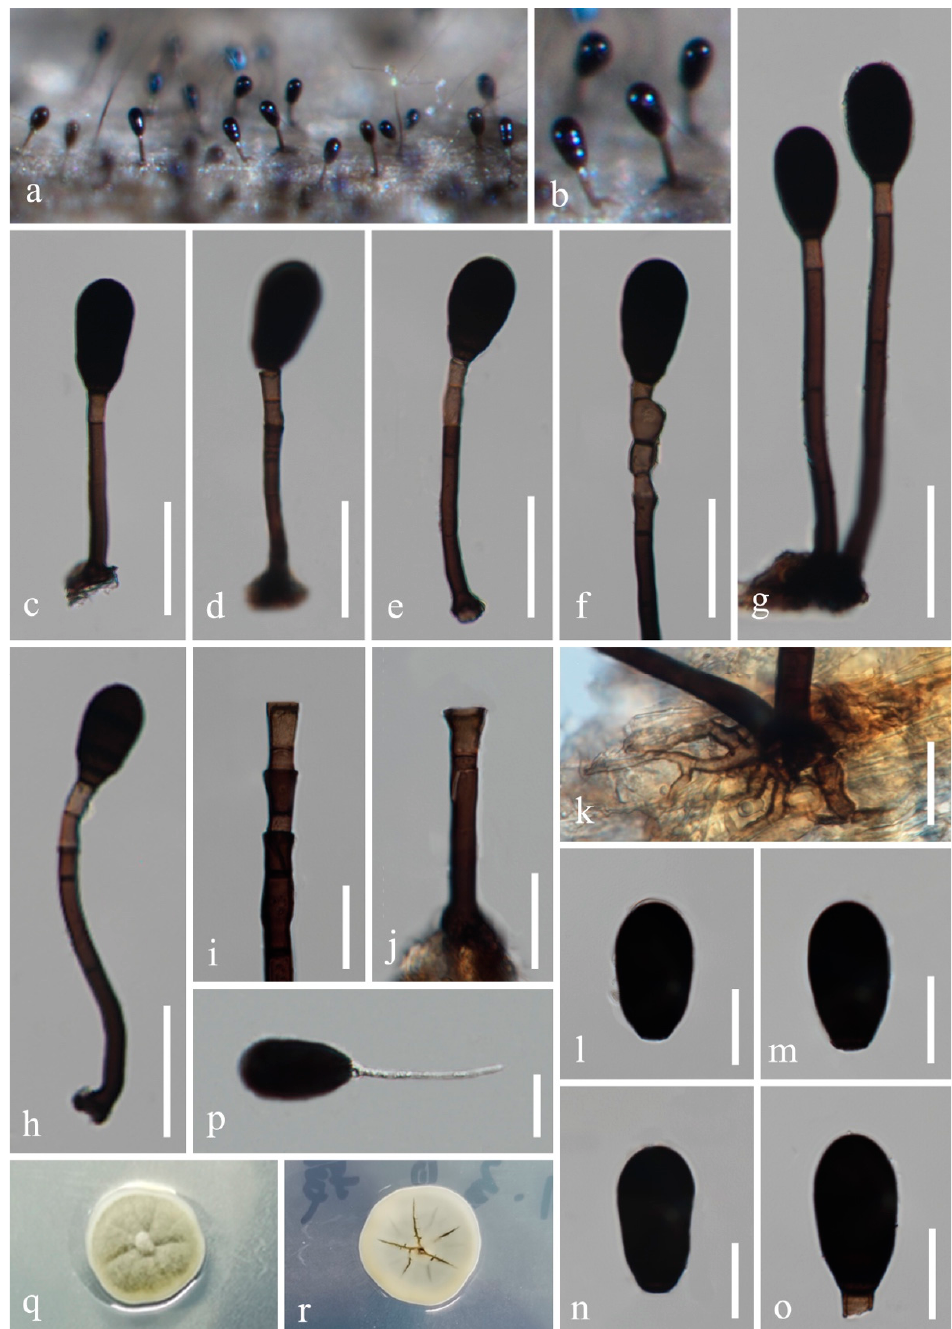
Figure 3. Mucispora aquatica (HKAS 122795, holotype). ( a , b ) Colonies on submerged wood. ( c – h ) Conidiophores with conidia. ( i , j ) Conidiogenous cells. ( k ) Mycelium. ( l – o ) Conidia. ( p ) Germinated conidium. ( q , r ) Colony on PDA (( q ) from above, ( r ) from below). Scale bars: ( c − h ) = 40 μ m, ( i − p ) = 20 μ m.